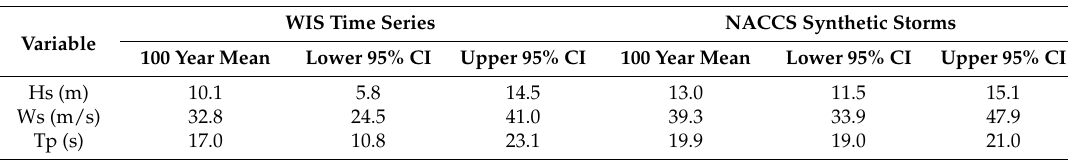
Table 1. Once in one hundred (100) year return period, mean and lower and upper 95% confidence interval (CI) limits for significant wave height and period and wind based on WIS hindcast data at station #63079 [20] and NACCS save point #6859